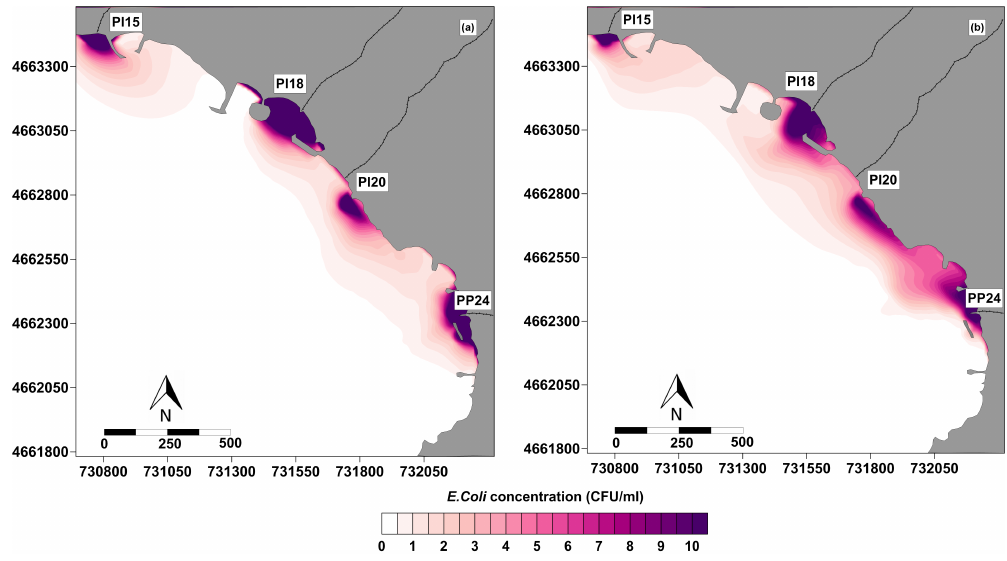
Figure 5. LC (a) and HC (b) simulation results of the bacterial dispersion in the Civitavecchia bathing areas. The distribution of E. coli concentration refers to the end of the simulation